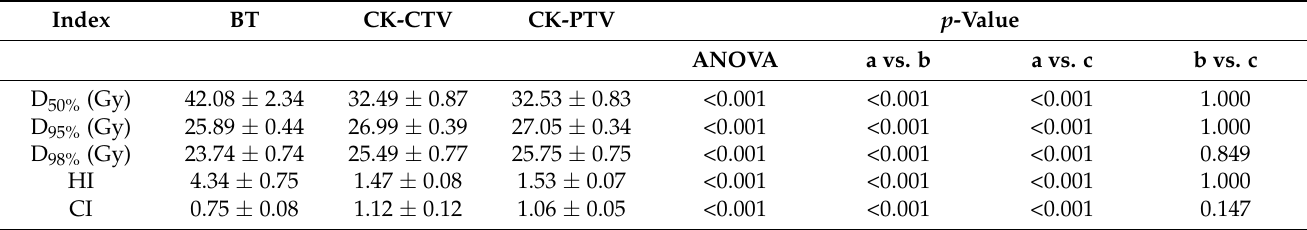
Figure 1. Axial, coronal and sagittal views of the dose distribution among the ( a – c ) BT plan, ( d – f ) CK- CTV plan and ( g – i ) CK-PTV plan for a representative patient. The 120% (33.6 Gy), 100% (28 Gy) and 80% (22.4 Gy) isodose lines are in light blue, dark blue, and brown, respectively. The images also illustrate the target volume in red, the rectum in green, the bladder in yellow and the sigmoid in pink. Table 2. Dose parameters comparison in relation to the target volume in the BT, CK-CTV and CK-PTV